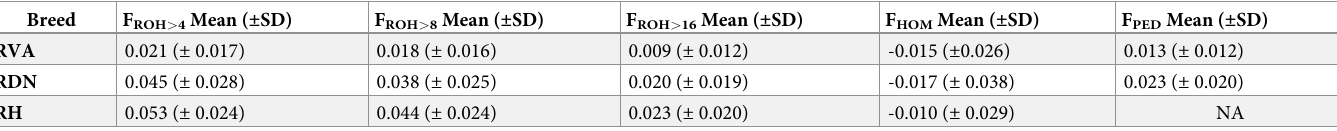
Table 4. Mean inbreeding coefficients calculated from ROH with minimum length of 4 (F ROH > 4 ), 8 (F ROH > 8 ), and 16 (F ROH > 16 ) Mb, from the excess of homozygos- ity (F HOM ) and from pedigree (F PED ) for Angler (RVA), Red-and-White dual-purpose (RDN) and Red Holstein